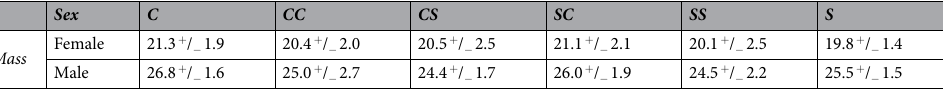
Table 2. Body mass at p60, mean and standard deviation.